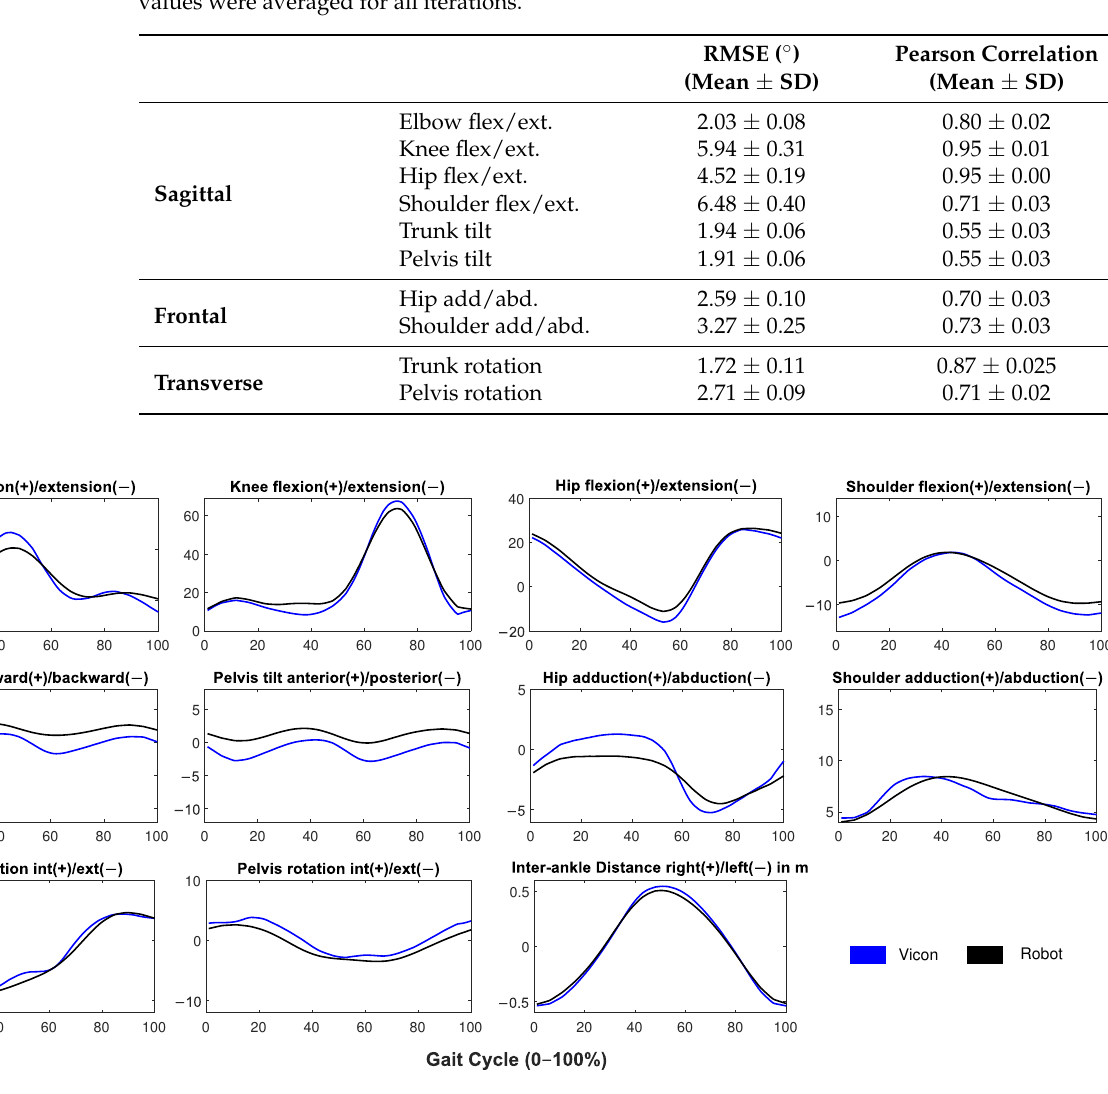
Figure 9. Comparison of kinematic gait cycles retrieved by the robot system (black line) and the Vicon system (blue line). The gait cycles are normalized from 0–100% and averaged for all of the